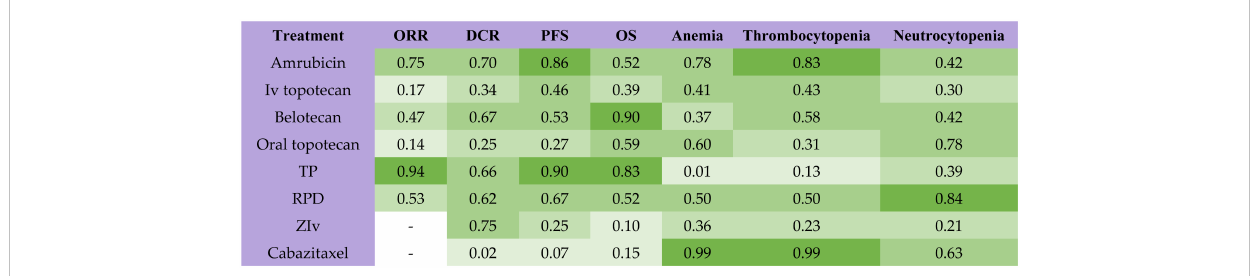
FIGURE 3 Rank probabilities with SUCRA value for different outcomes in 8 kinds of second-line treatments for patients sensitive to previous platinum-based chemotherapy. The deeper green color indicates more favorable outcomes. SUCRA, Surface under the cumulative ranking curve; ORR, objective response rate; DCR, disease control rate; OS, overall survival; PFS, progression-free survival; TP, TP, triple therapy containing platinum; RPD, rechallenge of platinum doublet; ZIv, ziv-a fl ibercept plus intravenous